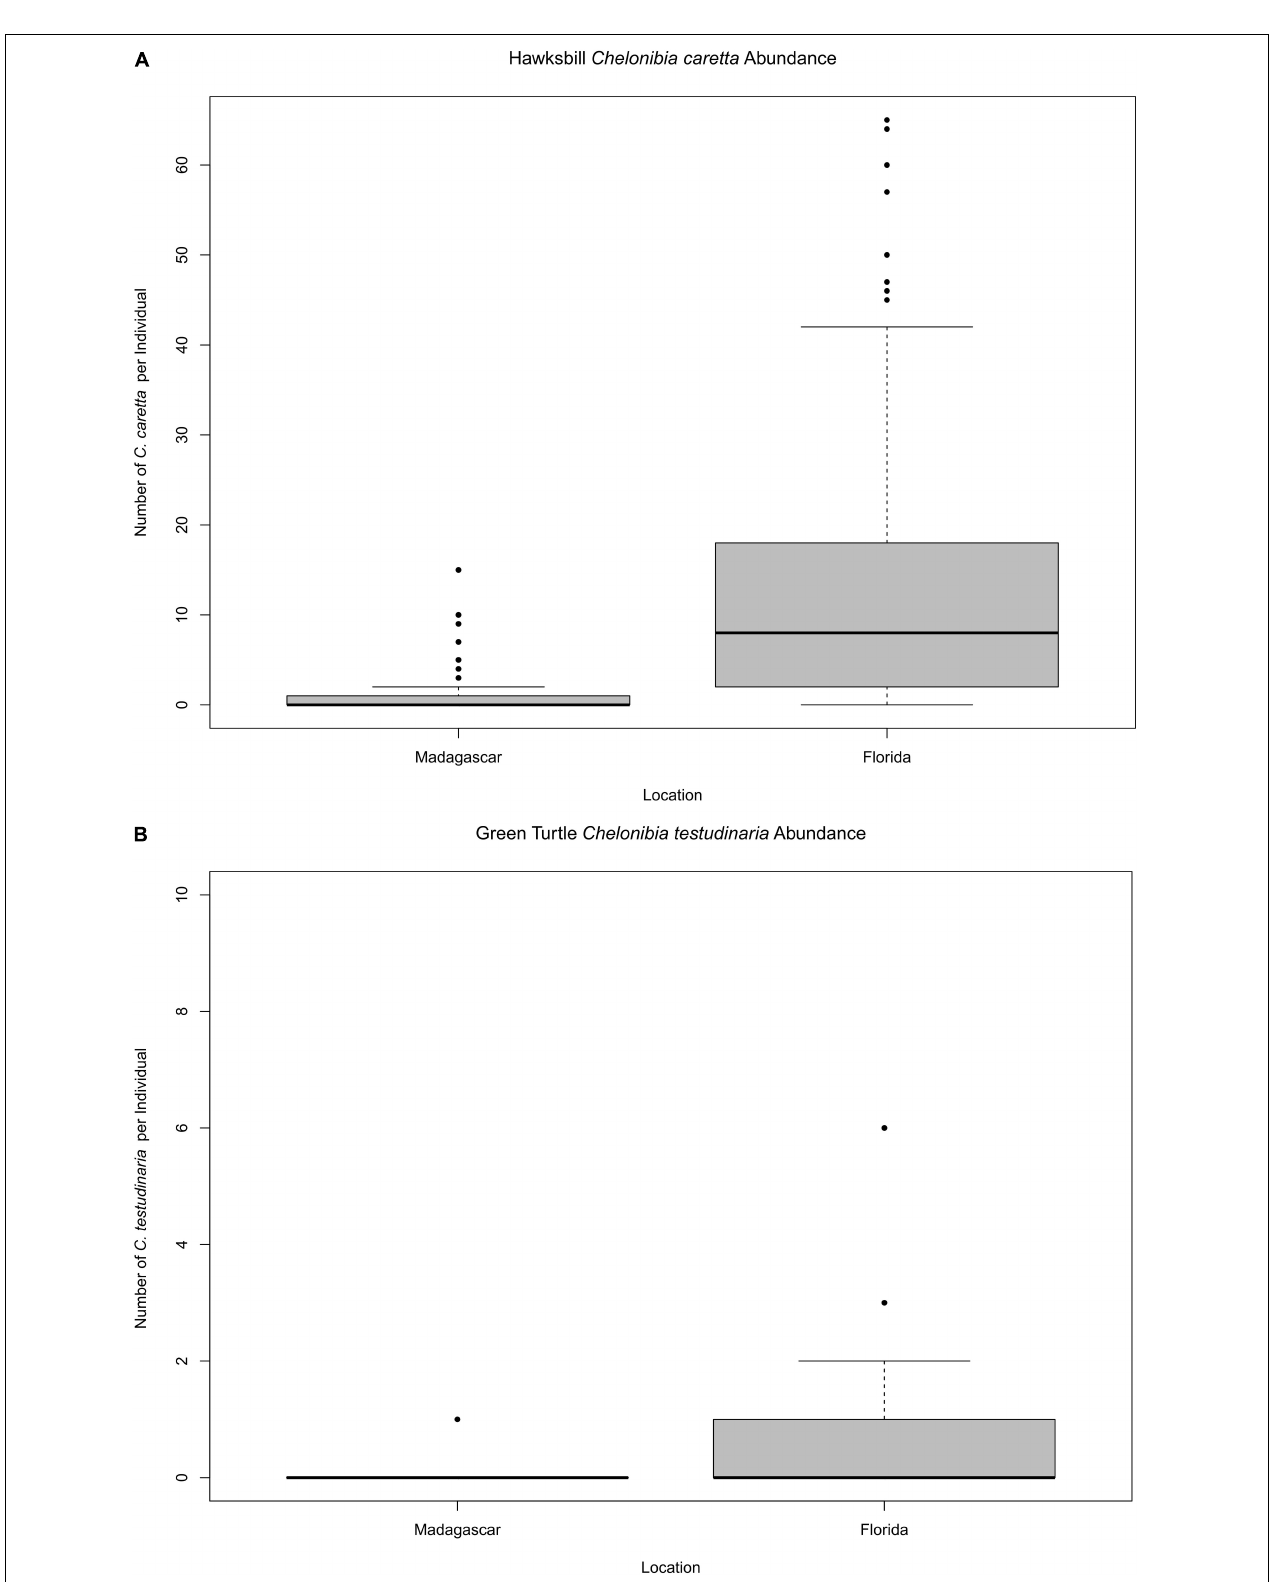
FIGURE 7 | Quantity of respective barnacles present on (A) hawksbill and (B) green turtles in Madagascar and Florida.